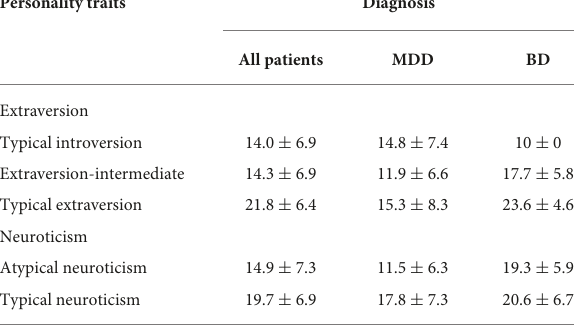
Table 3 for HCL-32 scores of subjects with different personality traits and